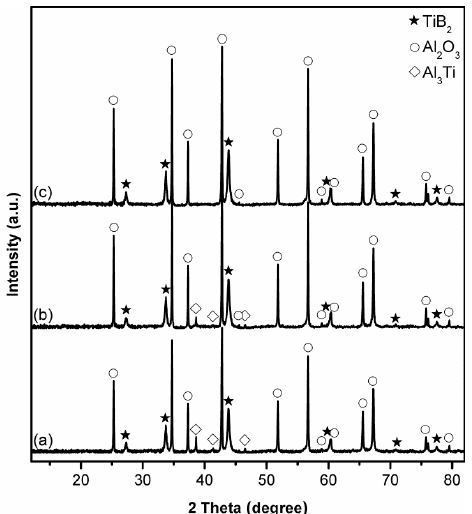
Figure 6. XRD patterns of samples after firing in NaCl at 1050 °C for 5 h using 30 wt% excess Al, and ( a ) 20, ( b ) 25, and ( c ) 30 wt% excess B 2 O 3.